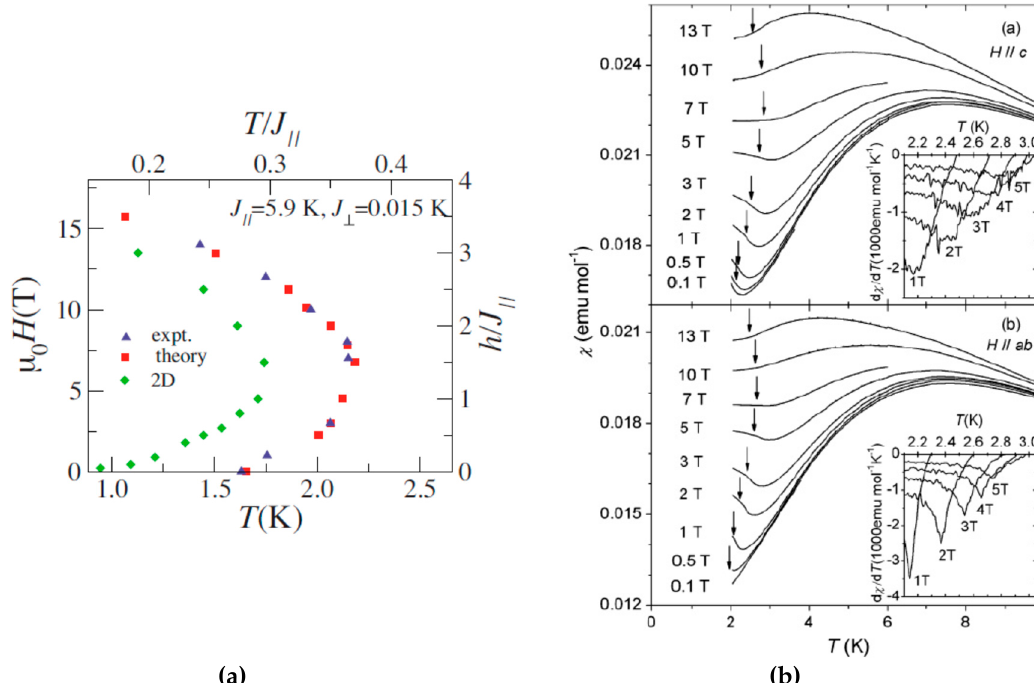
Figure 12. ( a ) Magnetic phase diagram of [Cu(HF 2 )(pz) 2 ]BF 4 compared with QMC simulations of the S = 1/2 HAF on the spatially anisotropic simple cubic lattice ( R = 1 within layers) with the system parameters ( J || ≡ J , J ⊥ ≡ J (cid:48)(cid:48) , h = g µ B µ 0 H ) . For comparison, the results for the pure 2D case ( J” = 0) are also shown. (Reproduced with permission from reference [108]); ( b ) χ ( T ) of [Cu(pz) 2 (pyO) 2 ](PF 6 ) 2 for the magnetic field applied perpendicular to the easy plane ab ( μ 0 H ‖ c ) and within the easy plane ab ( μ 0 H ‖ ab ). The arrows mark the positions of the specific heat peaks. The insets show ∂ χ ( T )/ ∂ T below 5 T. (Reproduced with permission from reference [90]).